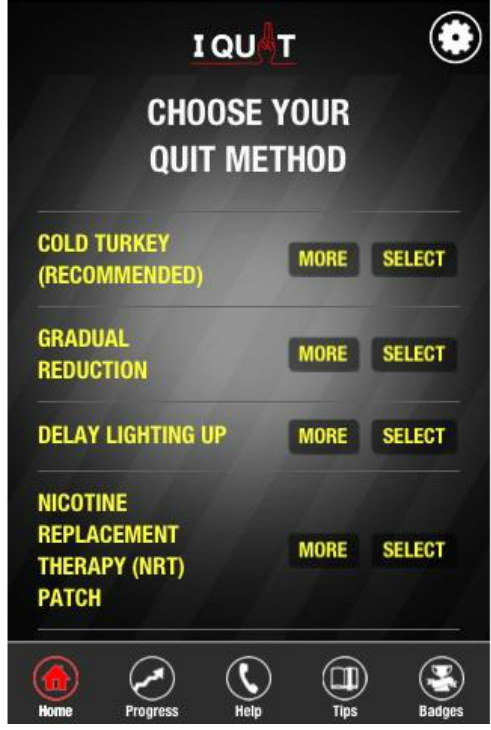
Figure 1. Screenshot of the HPB I Quit app by the Singapore Health Promotion